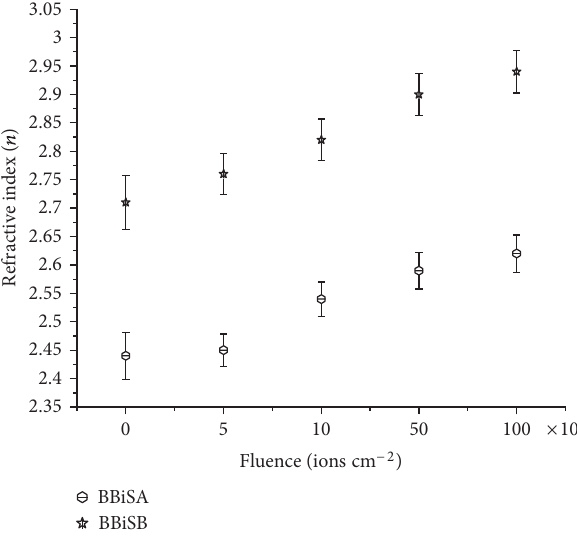
F 10: Showing the FTIR spectra of Li BBiSA